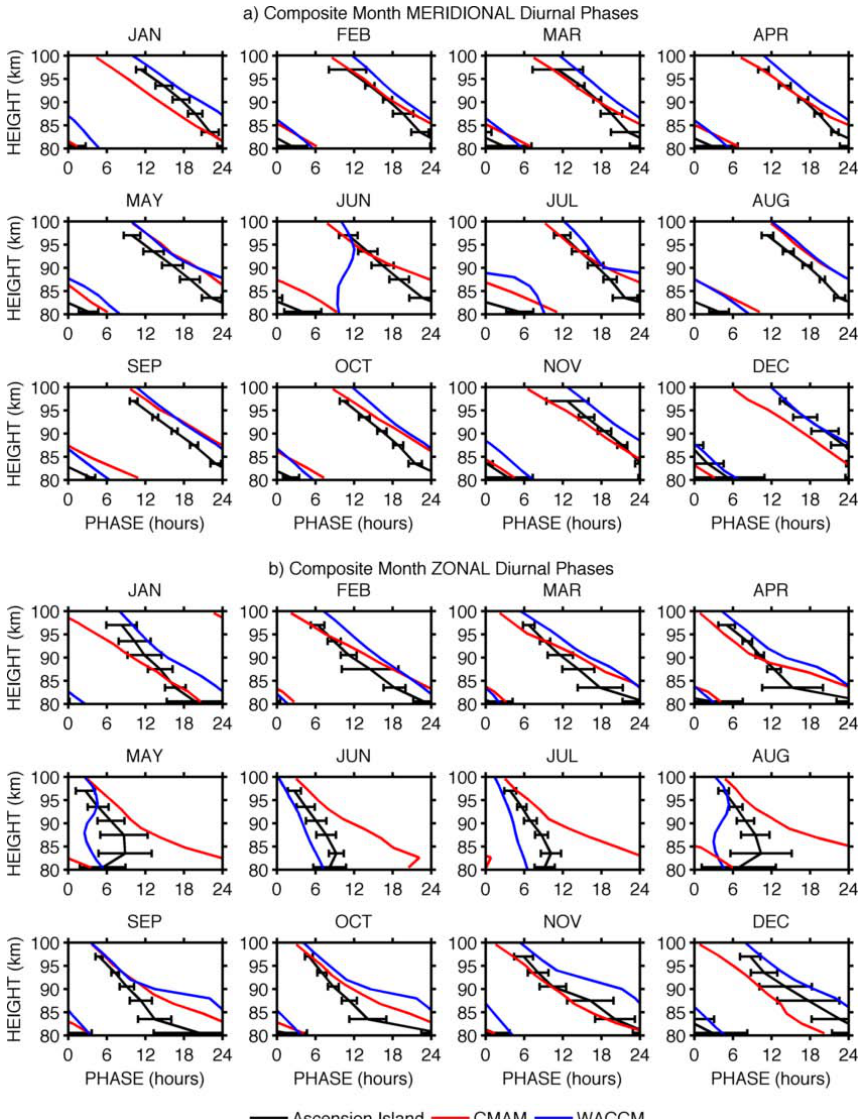
Fig. 8. Phases of the (a) meridional and (b) zonal diurnal tide as a function of month and height. The error bars on the radar observations (black lines) indicate the standard deviation of the individual monthly means over the interval 2002–2011. Also plotted are the predictions of eCMAM (red lines) and WACCM (blue